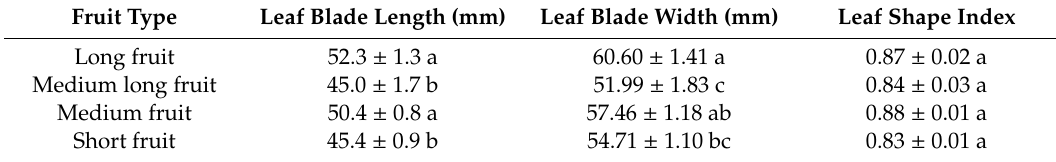
Table 4. True leaf shape traits of four types of cucumber fruits.